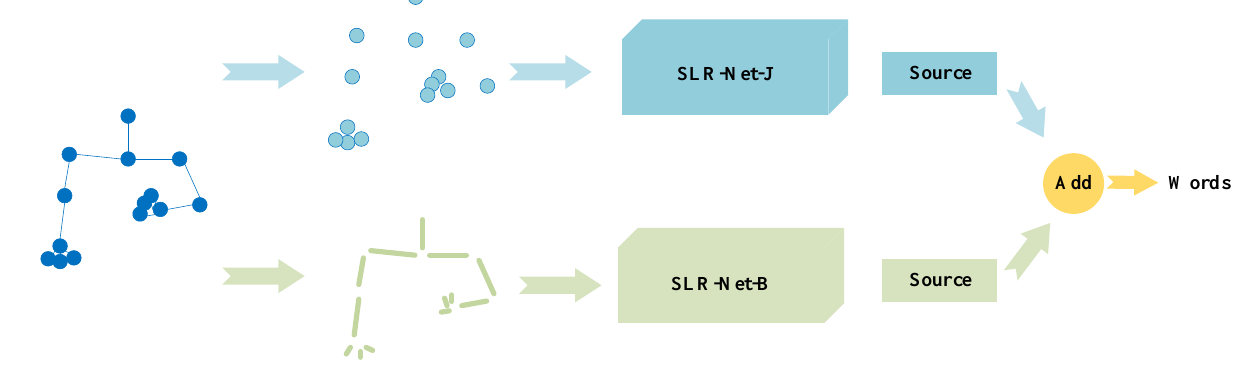
Figure 7. The structure of two-stream fused SLR-Net (SLR-Net-J+B).